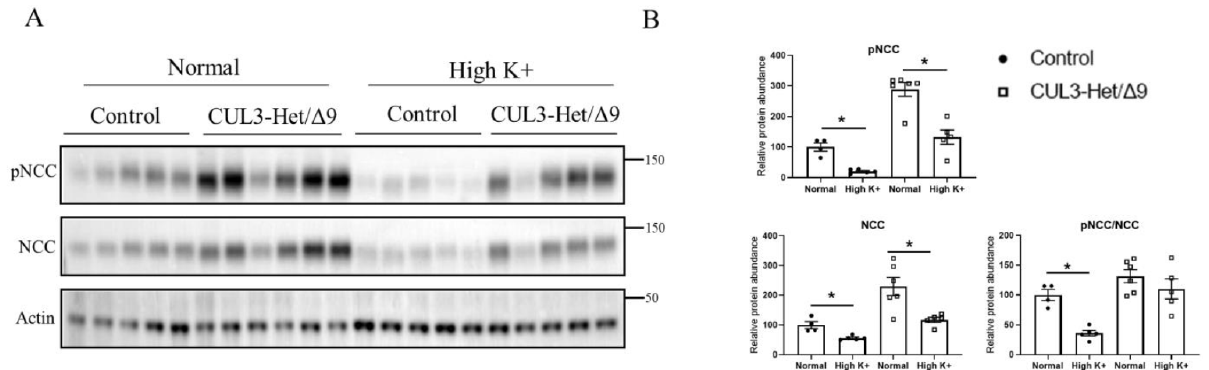
Figure 3. High dietary K + supplementation effects on NCC phosphorylation is attenuated in Cul3- ∆ 9 mice. ( A ) Representative immunoblots of pNCC, NCC, and actin in kidney homogenates of control and Cul3- ∆ 9 mice that were on either normal diet (control, n = 5, vs. Cul3- ∆ 9, n = 6) or high K +